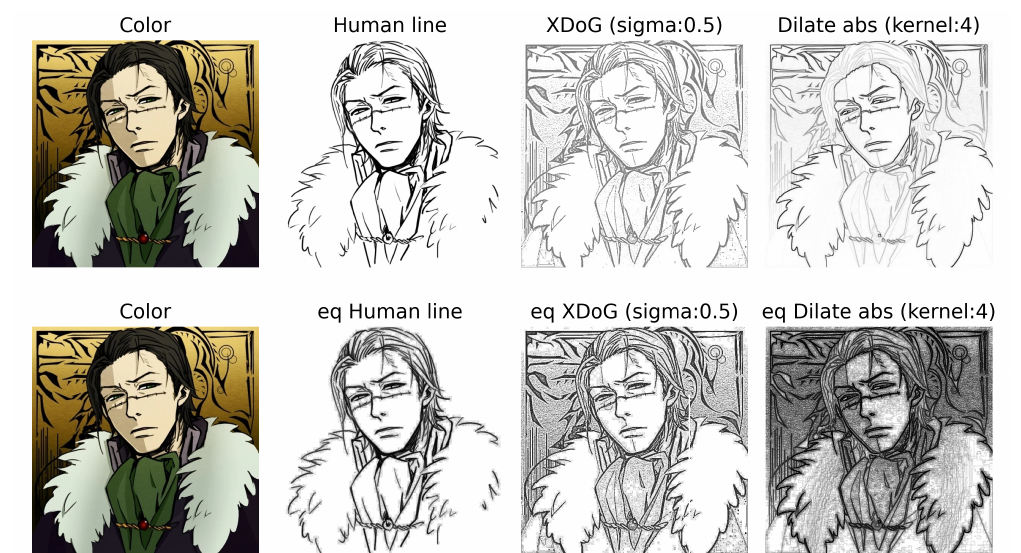
Figure 4. Line-art for Figure 3 (eq: histogram equalization).